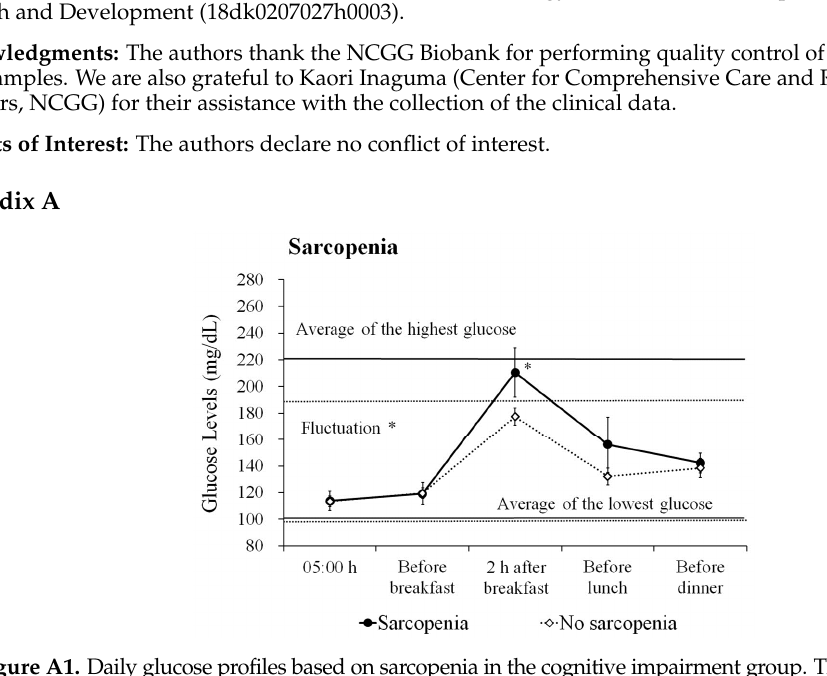
Figure A1. Daily glucose profiles based on sarcopenia in the cognitive impairment group. The figure shows the average ± standard error (SE) glucose level. Average of the highest glucose level: the average of the maximum glucose level of the day during the measurement period. Average of the lowest glucose level: the average of the minimum glucose level of the day during the measurement period. The solid line represents the sarcopenia group, and the dotted line indicates the no sarcopenia group. Fluctuation: the average of the diurnal range from the minimum glucose level to the maximum glucose level. * p < 0.05.